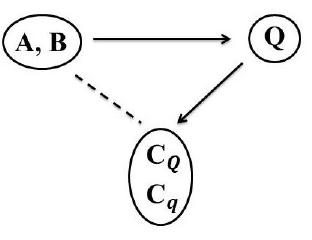
Figure 1. Quaternionic Nomenclature: Two symmetric-paired complex orthogonal designs (CODs) A and B generate a quaternion orthogonal design (QOD) Q , which gives rise to different quasi-codes C Q and C q with linear and decoupled